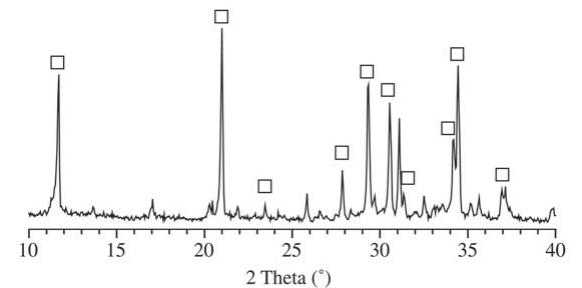
P O (JCPDF 9-346). 2 2 7